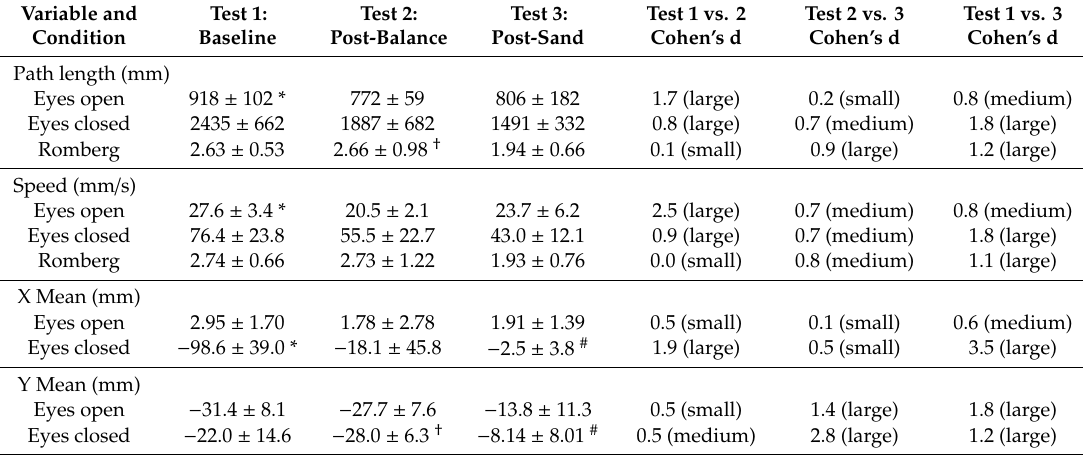
Table 3. Non-dominant monopedal stance. Parameters expressed as mean ±